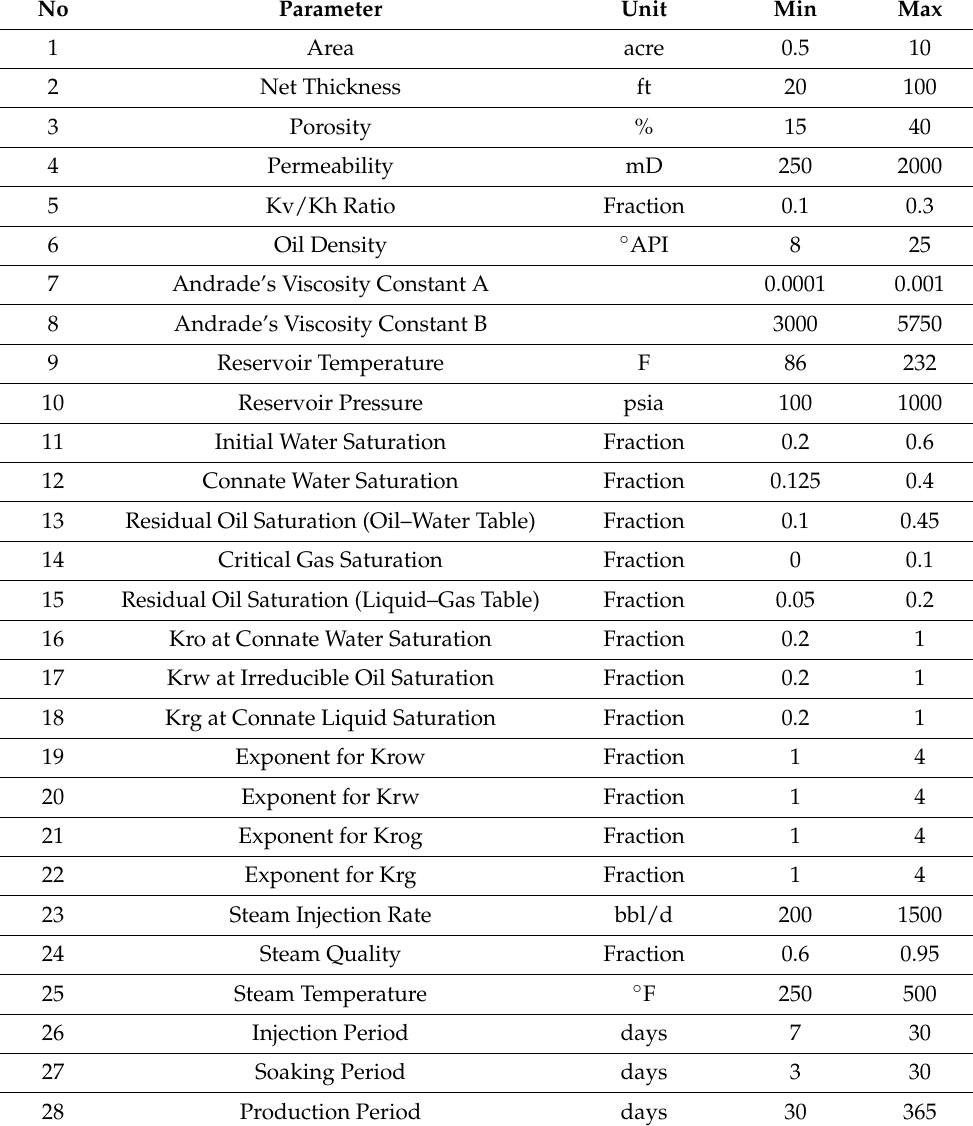
Table 1. Input variables for sensitivity analysis and predictive model